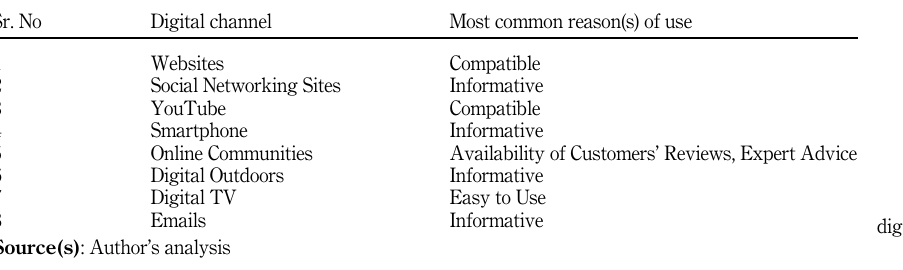
Table 10. Reason(s) of